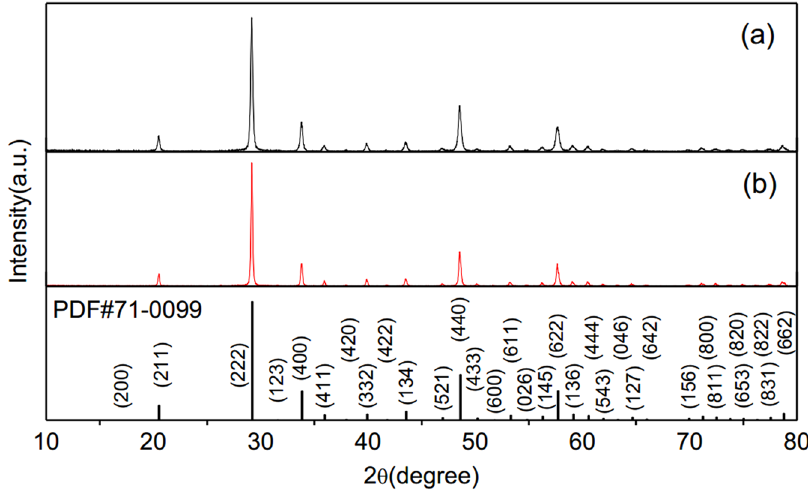
Figure 2. Powder XRD patterns of ( a ) Y 2 O 3 :1%Er 3 + , 1.5%Tm 3 + and ( b ) Y 2 O 3 :1%Er 3 + , 0.5%Ho 3 + . Below is the standard card.